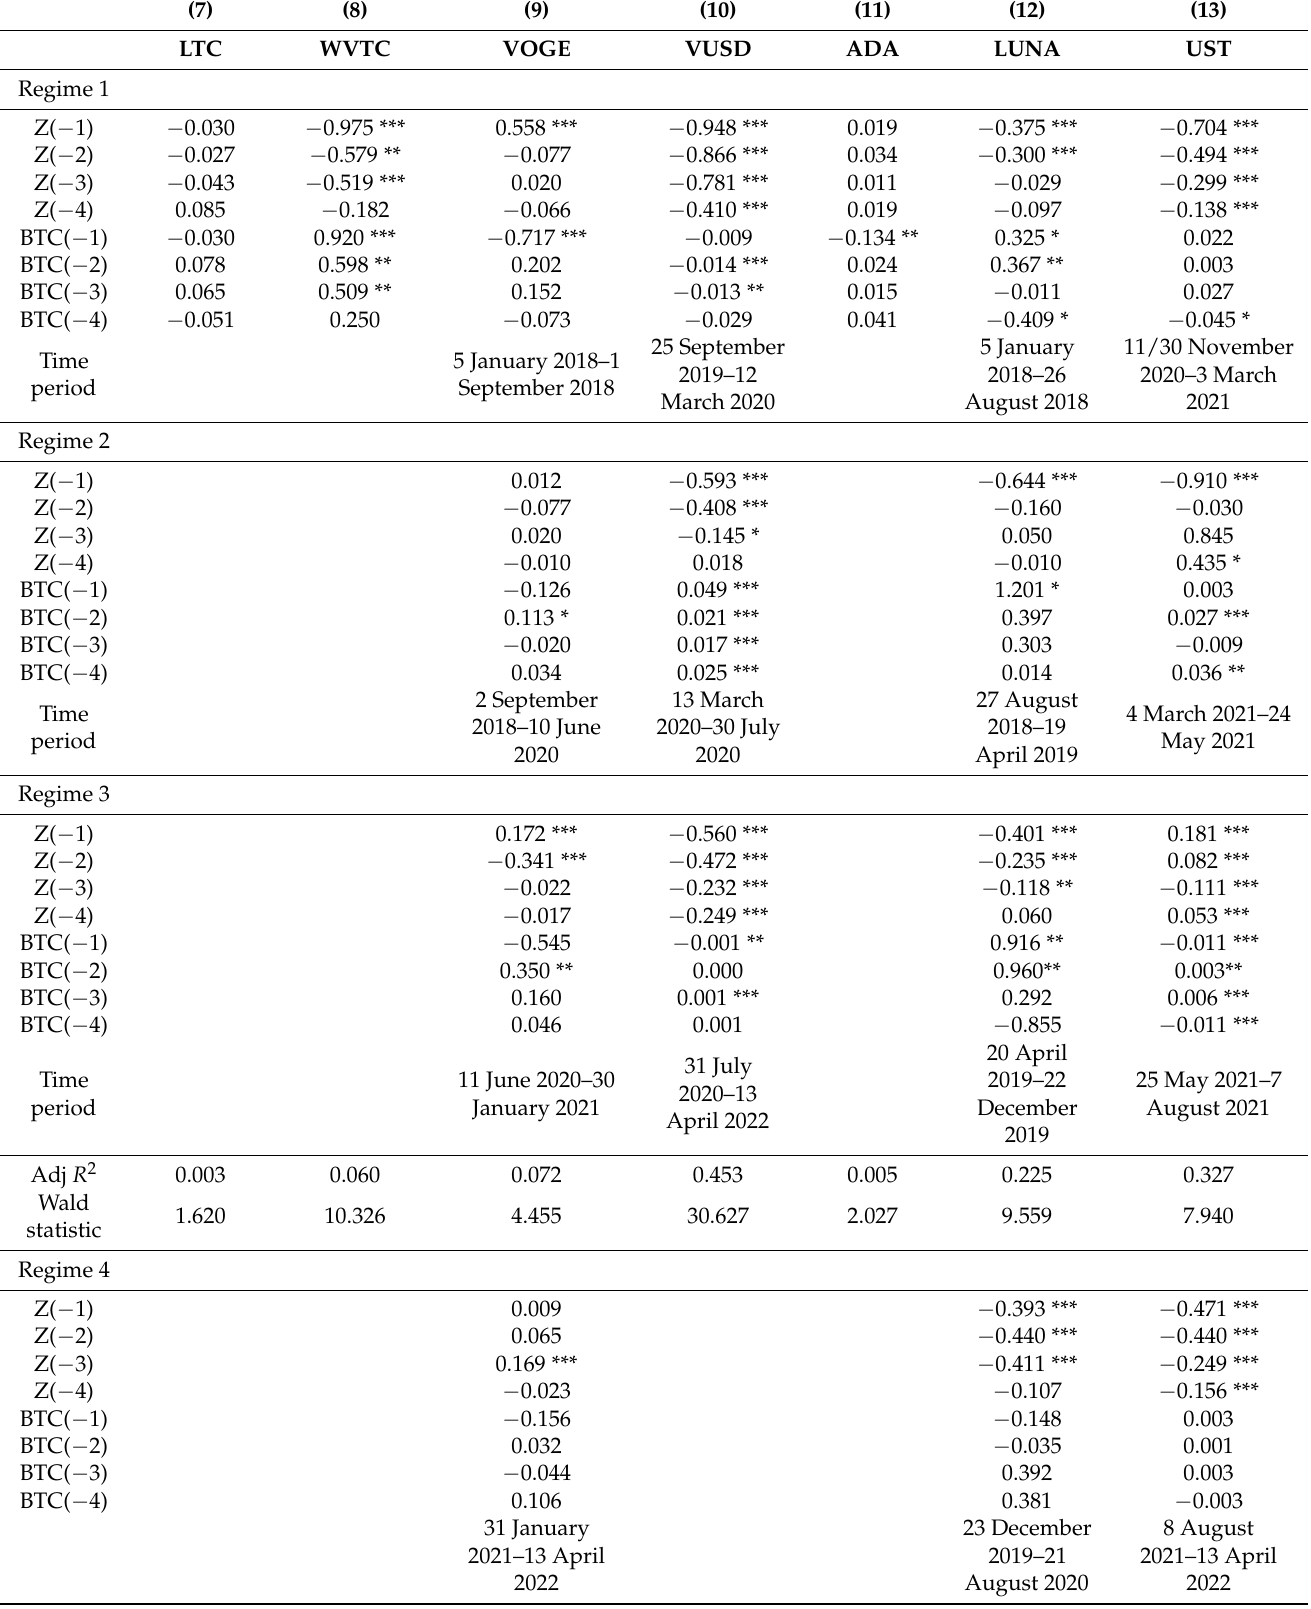
Table 3. Additional in-sample results for one-step-ahead forecasting with